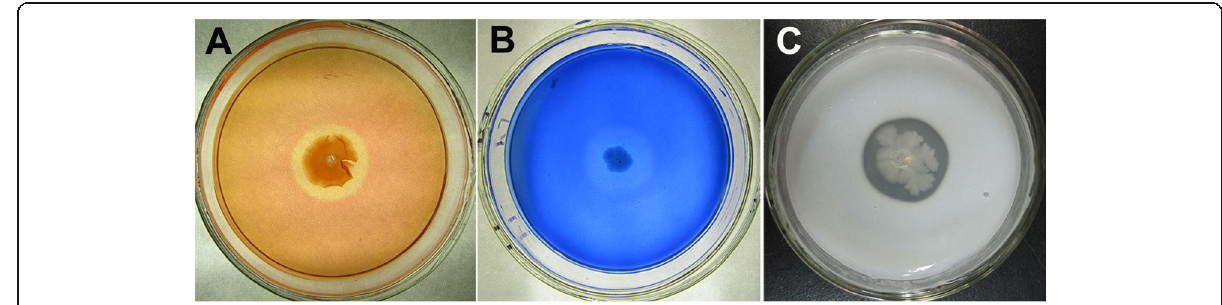
Fig. 3 Cell wall-degrading traits of strain ZSH-1. Production of cellulase ( a ), β -1,3-glucanase ( b ), and protease ( c ) is indicated by clear zones around the colonies on the plates